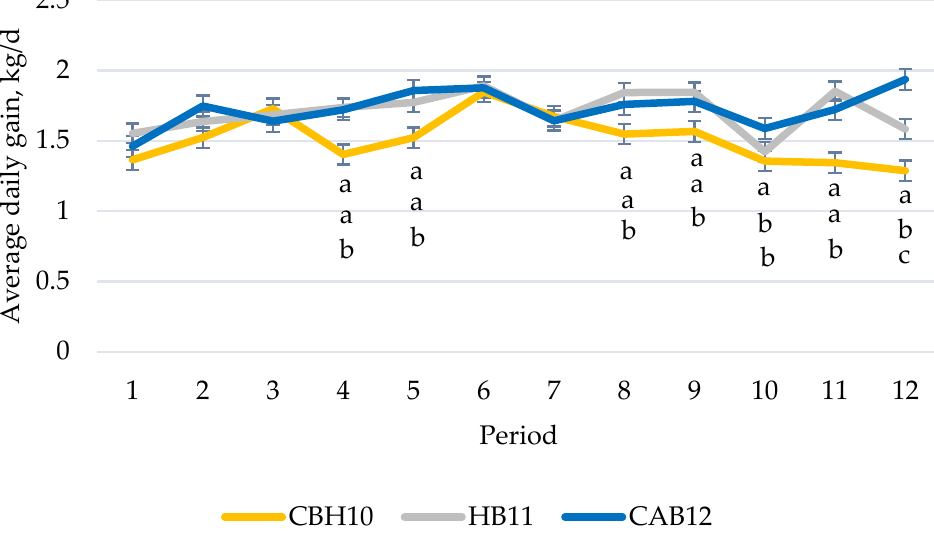
Figure 2. Average daily gain over the time in crossbred Holstein x beef breeds such as Charolais or Limousine heifers, slaughtered at 10 months of age (CBH10); Holstein bulls, slaughtered at 11 months of age (HB11); and crossbred Holstein with Angus bulls, slaughtered at 12 months of age (CAB12) ( a,b,c significant differences ( p < 0.05) between production system within the same period).